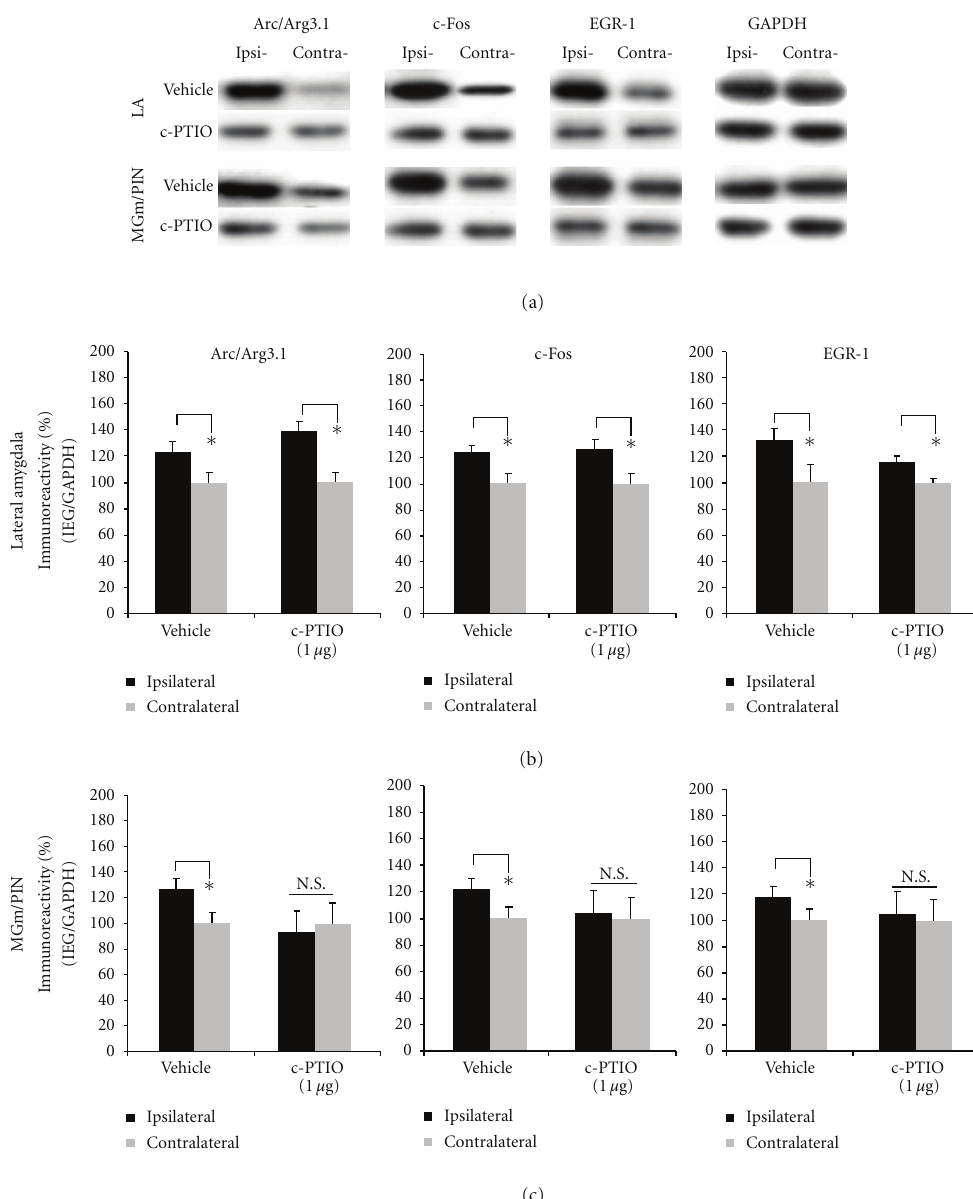
Figure 8: Pharmacological blockade of extracellular NO in the LA impairs ERK-driven IEG expression in the MGm/PIN, but not the LA, following HFS. (a) Images of Western blots for Arc/Arg3.1, c-Fos, EGR-1, and GAPDH from both LA (top) and MGm/PIN (bottom) samples. (b) Mean ( ± SEM) percent Arc/Arg3.1, c-Fos, and EGR-1 immunoreactivity from LA punches taken from rats given intra-LA infusion of 50% DMSO (vehicle; n = 8) or 1 μ g/side c-PTIO ( n = 8). (C) Mean ( ± SEM) percent Arc/Arg3.1, c-Fos and EGR-1 immunoreactivity from MGm/PIN punches taken from rats given intra-LA infusion of 50% DMSO (vehicle; n = 8) or 1 μ g/side c-PTIO ( n = 8). In each figure, IEG levels have been normalized to GAPDH for each sample, and IEG expression on the ipsilateral side has been expressed as a percentage of that on the contralateral side for each rat. ∗ P < . 05 relative to the ipsilateral side N.S. = not